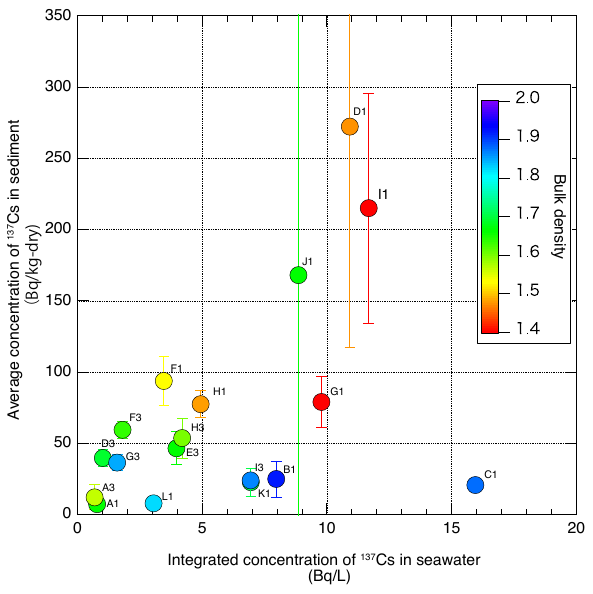
Fig. 10. Average 137 Cs concentrations in sediments, integrated 137 Cs concentrations in seawater, and average sediment bulk den- sities at the sampling stations where seawater concentrations were available during six cruises from May to July 2011. Integrated con- centrations of 137 Cs in seawater were calculated to sum all the data obtained in the six cruises for each station. Average 137 Cs con- centrations in sediments were calculated for samples obtained from September 2011 to February 2012. Error bars indicate the standard deviations of the sediment